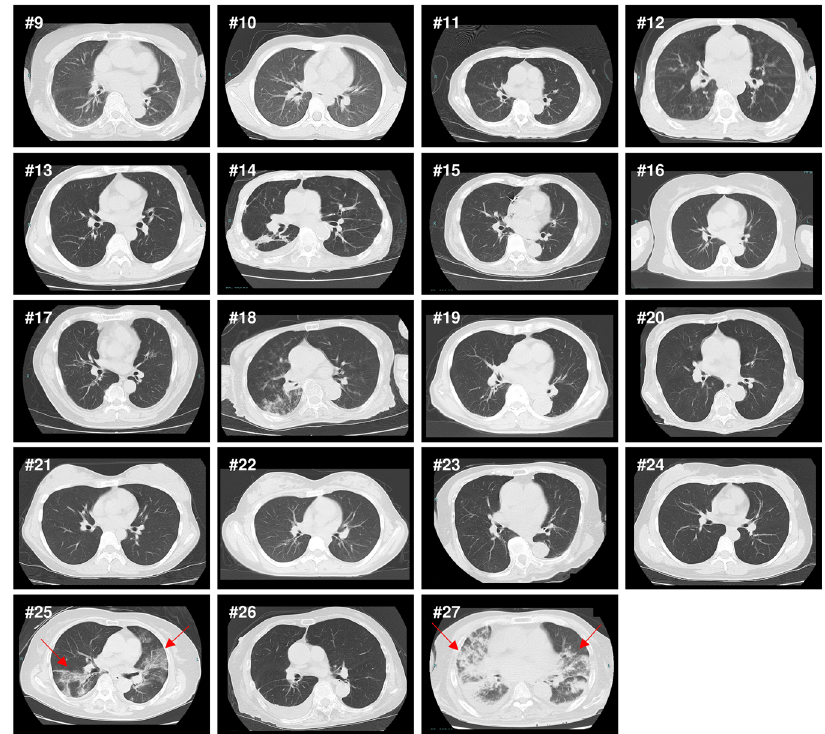
Fig. 5 Nineteen cases of BA.2 infection in unvaccinated patients. Chest CT images of the 19 unvaccinated cases who infected with BA.2. These CT scans were taken immediately upon admission to the hospital. Red arrows indicate sites of